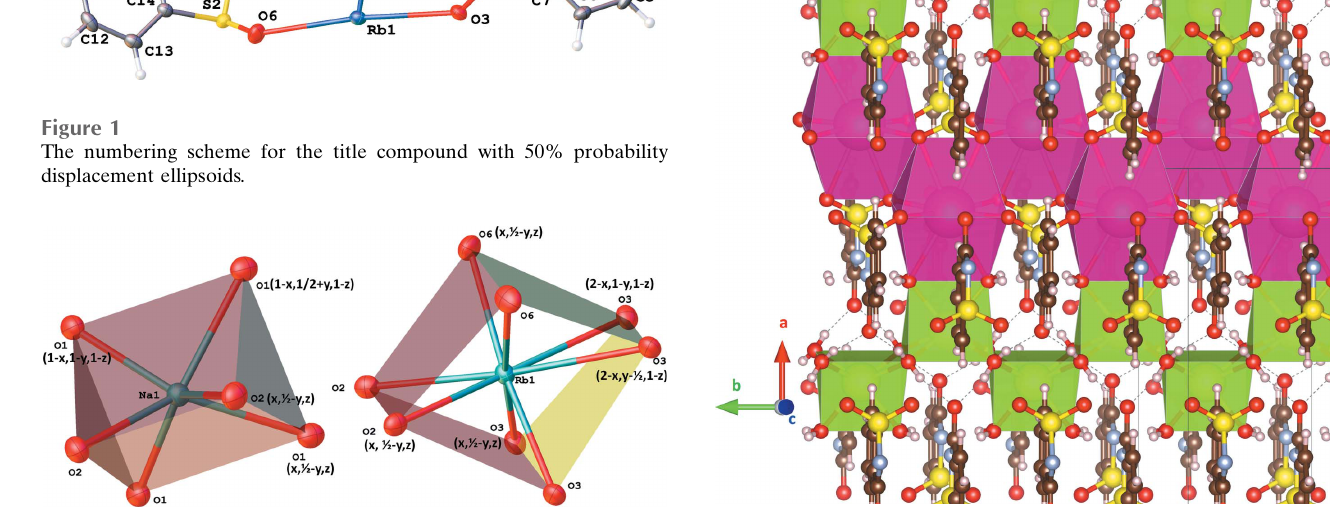
Figure 2 Coordination polyhedra of the metal ions in I . For bond lengths and symmetry codes, see Table 1.